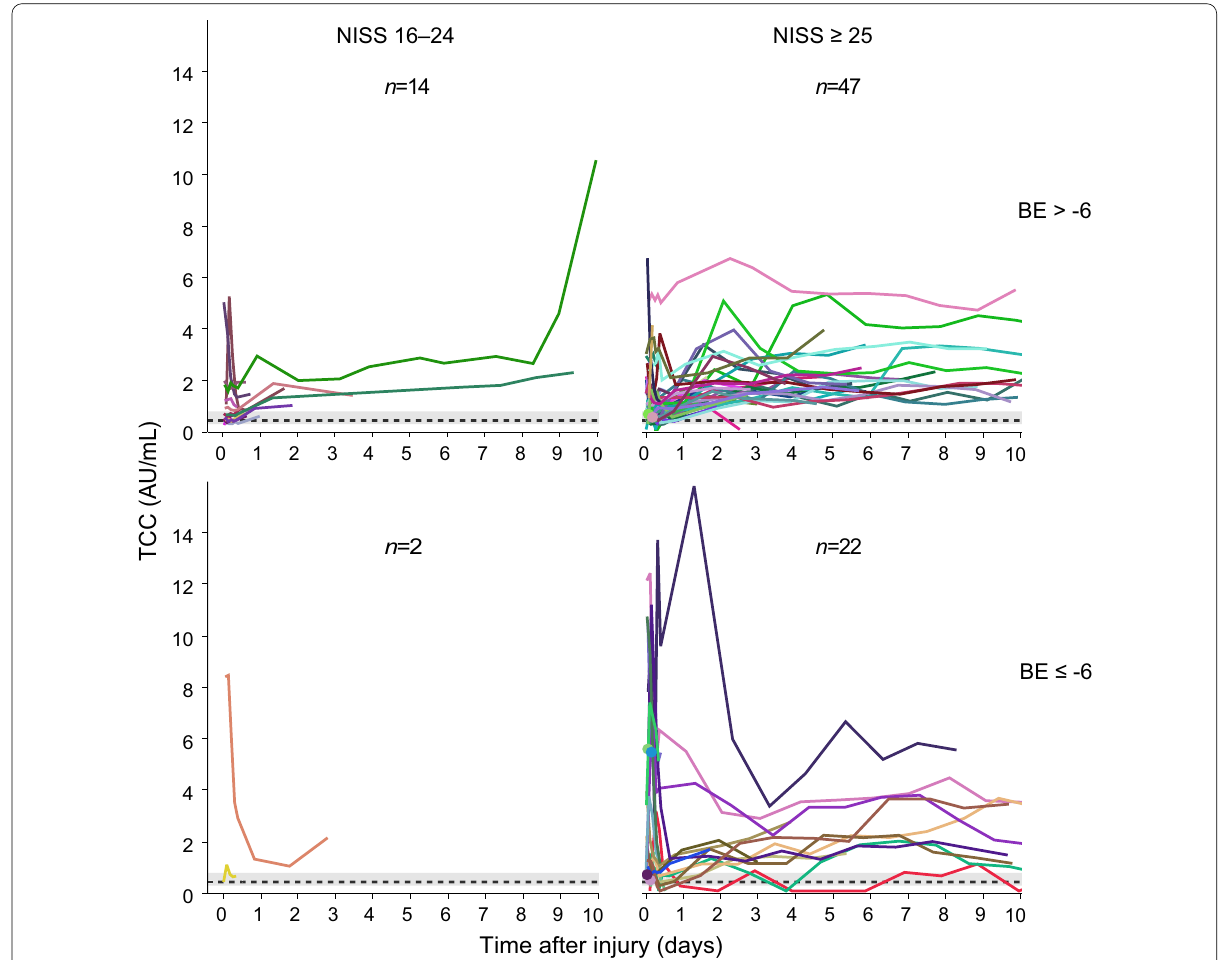
Fig. 2 Complement activation during the first 10 days after trauma. Individual Terminal Complement Complex (TCC) concentration curves 0–10 days after injury for the 136 trauma patients constituting the study population. Black dashed lines represent median TCC concentration and grey corresponding areas interquartile range for the reference population of 20 healthy volunteers. Individual patients’ concentration curves are drawn in the same color as in Fig.